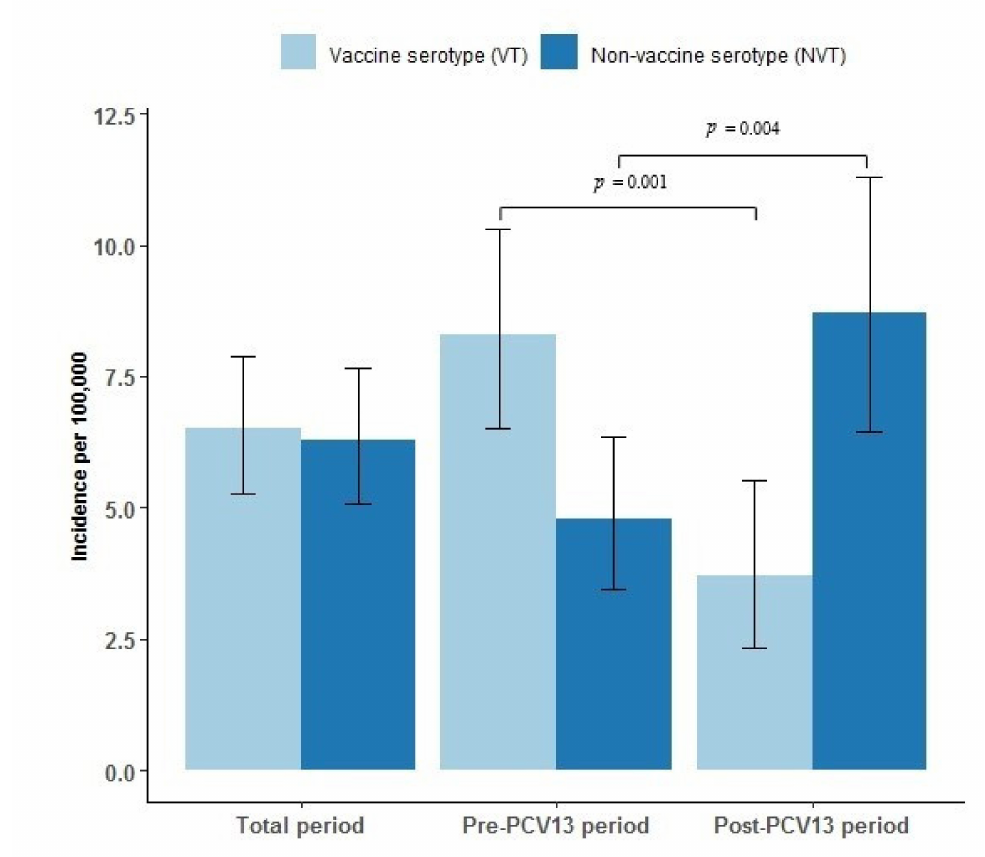
Figure 3. Incidence and confidence intervals of vaccine serotype (VT) and non-vaccine serotype (NVT) invasive pneumococcal disease (IPD) per 100,000 person years in Greenland 1995–2020, overall, pre (1995–2010), and post (2010–2020) introduction of the 13-valent pneumococcal conjugate vaccine (PCV13) to the childhood vaccination program in 2010 in Greenland. Confidence intervals are marked as black error bars. Differences between the pre-PCV13 and the post-PCV13 periods are marked with a horizontal black line and denote statistical significance at the p < 0.05